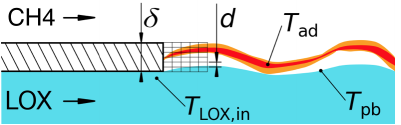
Figure 9. Shear layer with anchored flame behind coaxial injector. LOX post thickness δ , mesh resolu- tion d , LOX temperature T LOX,in , adiabatic flame temperature T ad , pseudo boiling temperature T pb